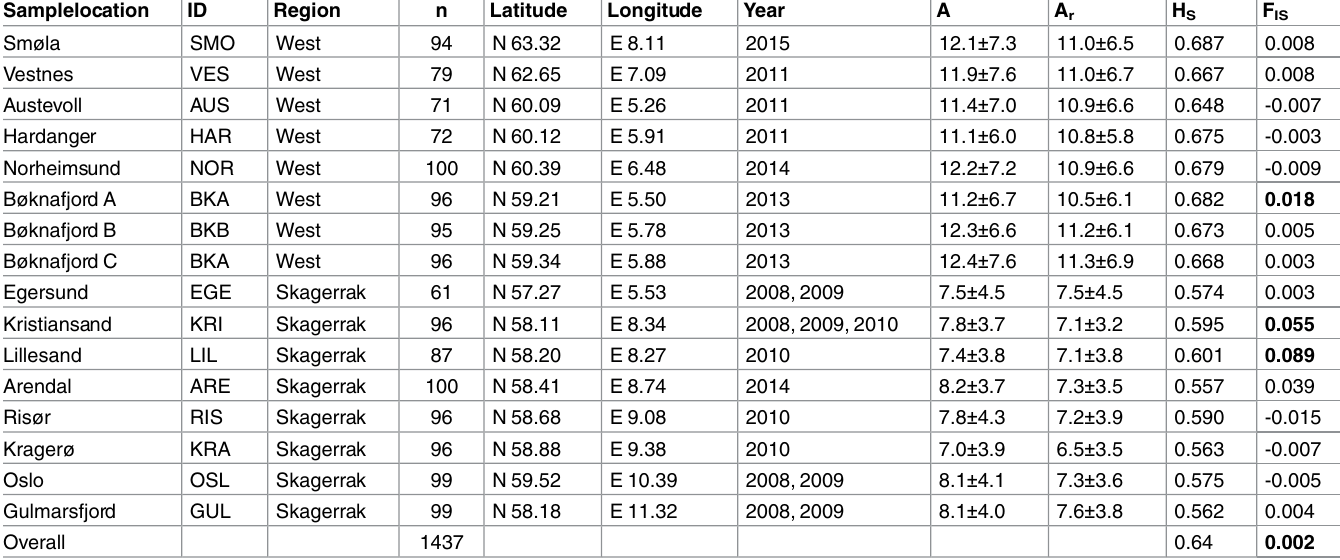
Table 1. Sampleinformation and summarystatisticsfor geneticvariabilityin corkwingwrasse samples. n = samplesize, A = average numberof alleles per locus ± standarddeviation, A r = average allelicrichnessper locus ± standarddeviation. H S = gene diversity. F IS = deviation fromHardy-Weinberg genotypeproportions. Numbers in bold indicatelocus deviating significantlyfromHardy-Weinbergexpectation at 5% level afterthe False Discovery Rate approach[42].